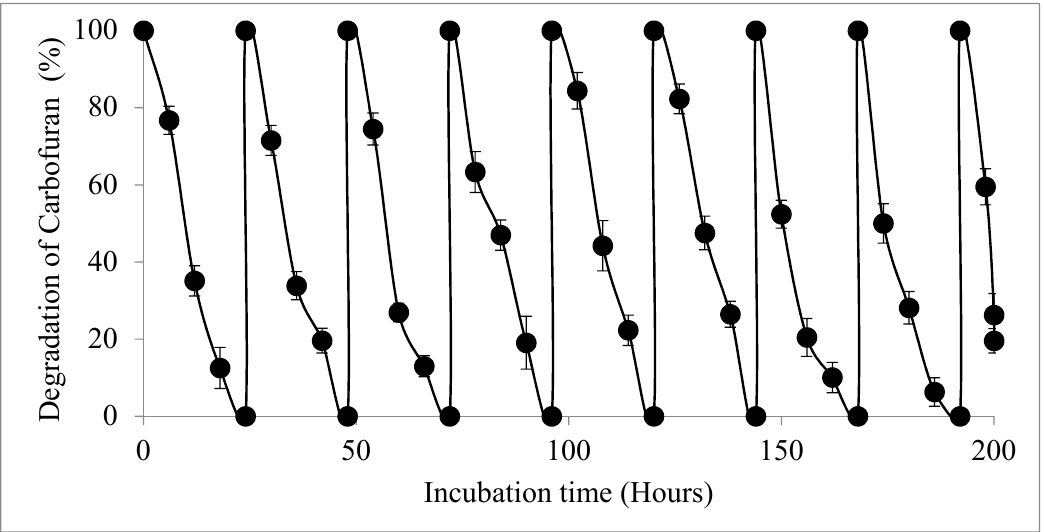
Figure 4. Repeated batch cycles of immobilized Enterobacter sp. Data is displayed for repeated usage only, and each cycle involved 24 h cycle. Data represent mean ± SD.